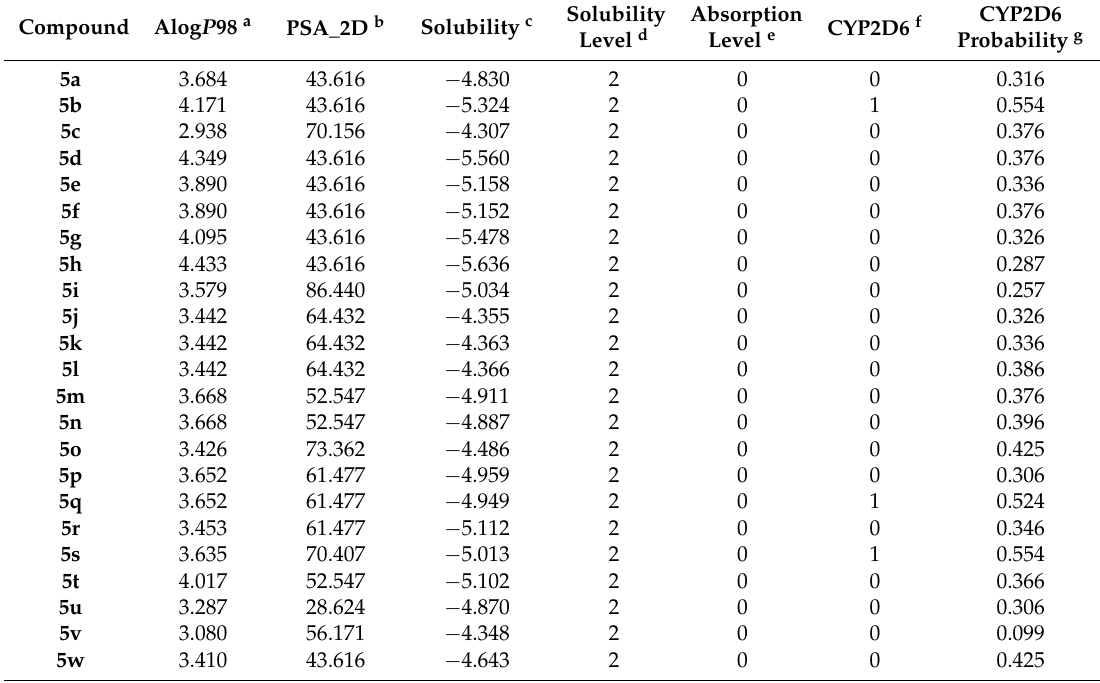
Table 7. Computer-aided ADME study of the prepared